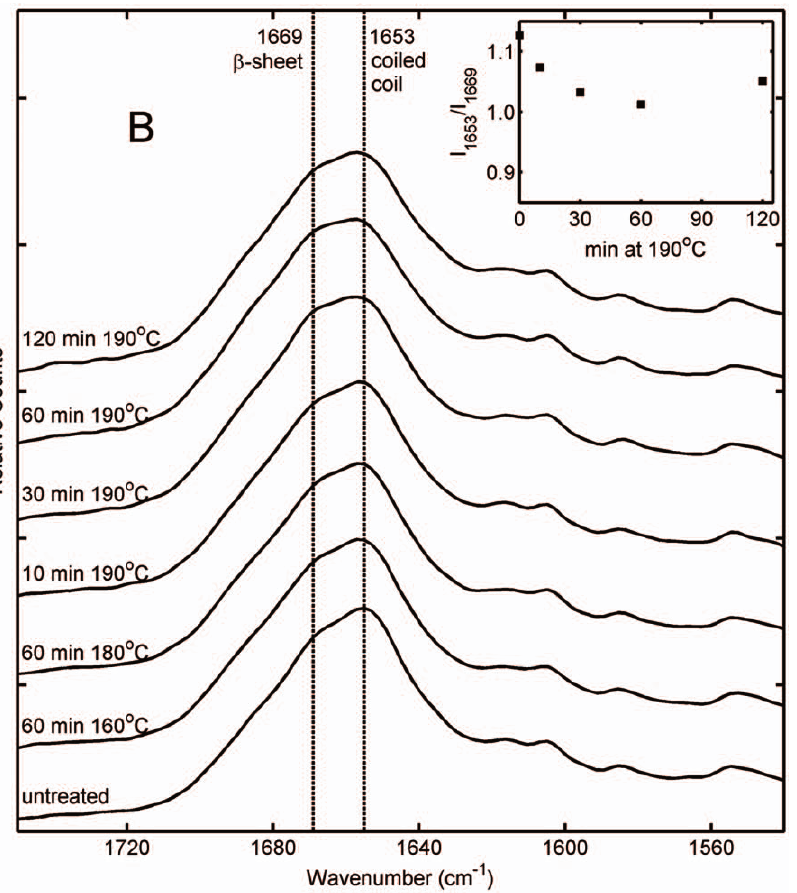
Figure 3. Raman spectra of honeybee silk sponges treated by heating at different temperatures for periods of 10–120 min. Inset shows the approximate ratio of Raman intensity at 1653 cm 2 1 (attributed to coiled coil protein structure) to intensity at 1669 cm 2 1 (attributed to ß- sheet protein structure) for different samples.